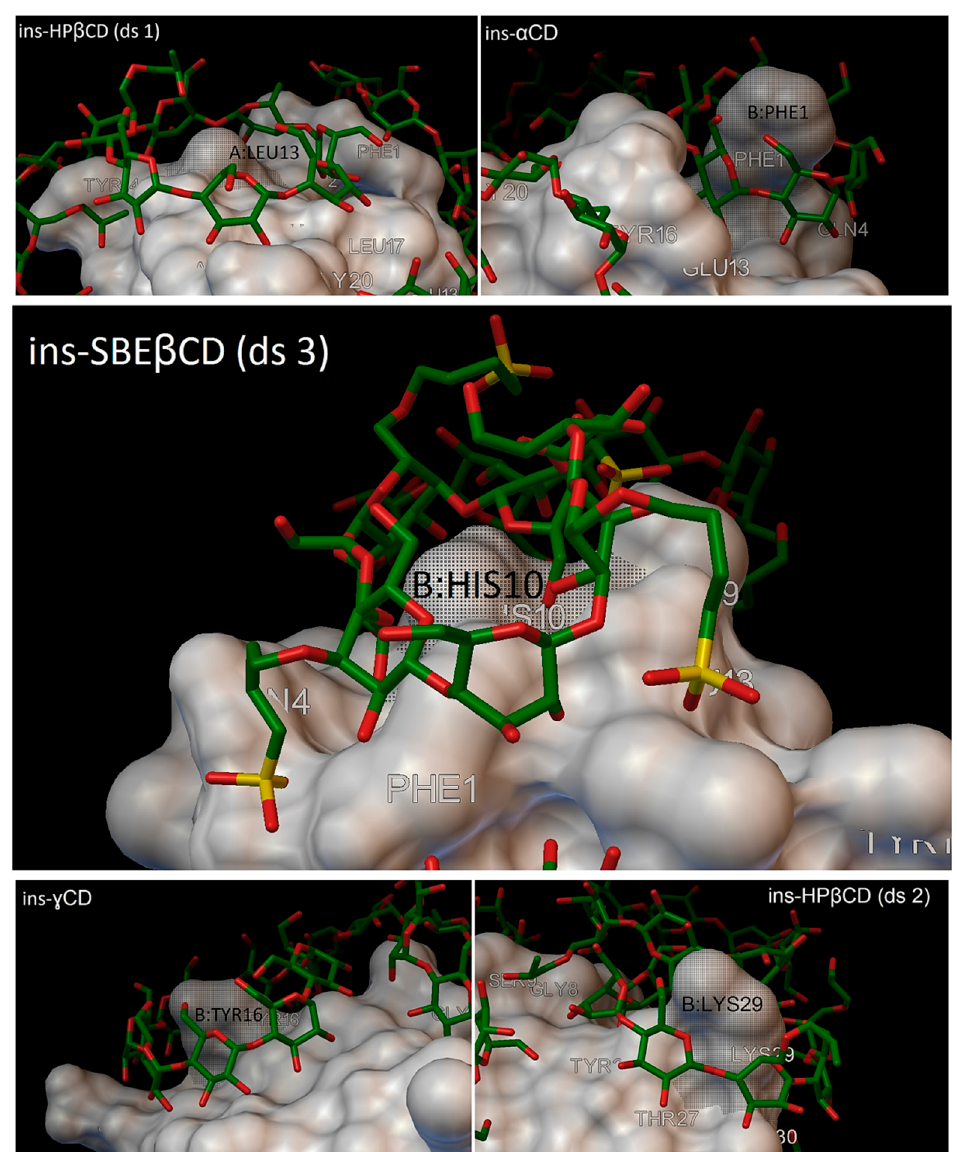
Figure 15. Up, left: residue A:LEU13 entering in the cavity of the hydroxypropyl- β -cyclodextrin (DS 1). Up, right: residue B:PHE1 entering in the cavity of the α -cyclodextrin. Middle: residue B:HIS10 entering in the cavity of the sulfobutylether- β -cyclodextrin (DS 3). Down, left: residue B:TYR16 entering in the cavity of the γ -cyclodextrin. Down, right: residue B:LYS29 entering in the cavity of the hydroxypropyl- β -cyclodextrin (DS 2).